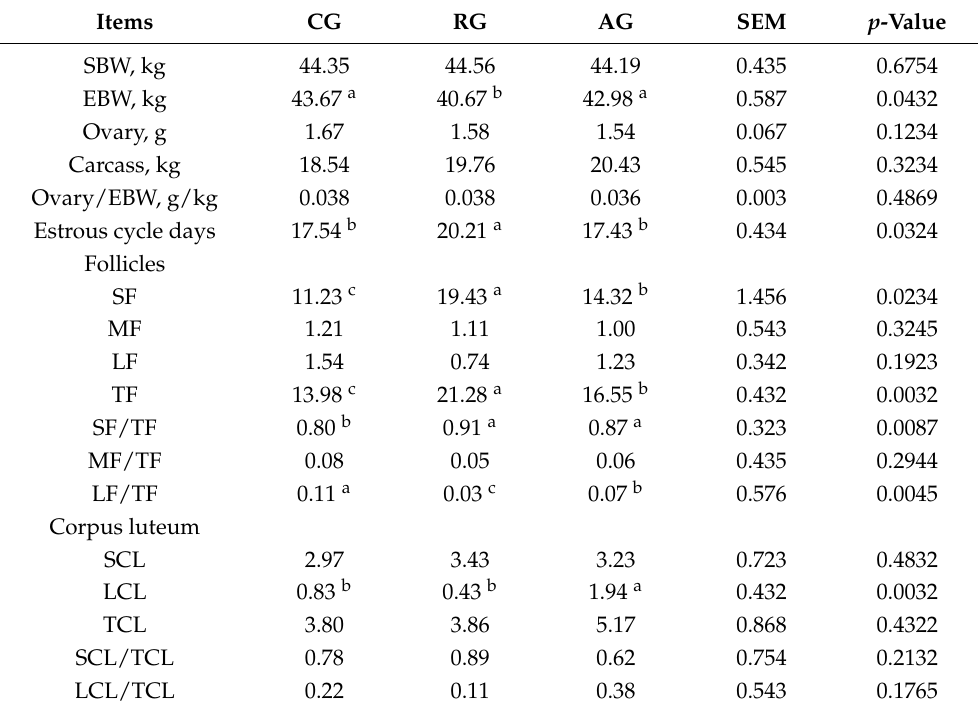
Table 3. Effects of diet and arginine on body weight, ovarian weight, and the number of follicles and corpus luteum in ewes 1